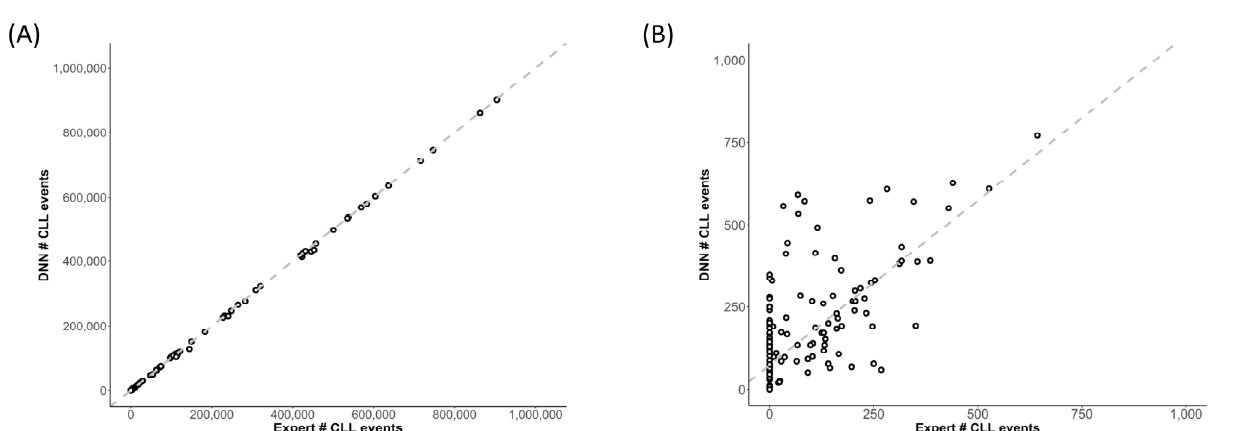
Figure 2. Scatterplots showing expert analysis and DNN inference of abnormal CLL events in the test cohort. ( A , B ) F ‐ DNN inferences showed excellent correlation with the expert abnormal CLL event counts (Pearson correlation coefficient, r > 0.99); ( A ), except at abnormal CLL event counts less than 1000 (r = 0.70). ( B ) The dashed line represents the Passing–Bablok regression line for the F ‐ DNN inferences versus the expert “ground truth”: slope = 1.001 (95% CI: 0.998–1.010) and intercept = 74.000 (95% CI: 60.831–93.835). ( C ) The L ‐ DNN showed an improved correlation with the expert “ground truth” at abnormal CLL event counts less than 1000 (r = 0.96). ( D ) Using the F ‐ DNN infer ‐ ence if greater than or equal to 1000 abnormal events and the L ‐ DNN inference if less than 1000 abnormal events resulted in excellent correlation throughout the analyzed range (r > 0.99) with a Passing–Bablok regression slope of 0.998 (95% CI: 0.995–1.000) and the intercept of 0.000 (95% CI: 0.000–0.046), shown in subplots ( C , D ). 3.2. DNN Optimization For further optimization, a separate DNN with similar architecture to the F ‐ DNN was trained using cases with CLL MRD events < 1000 (L ‐ DNN). The training dataset in ‐ cluded most of the cases (138 of 202) and a total of 145,748,173 events. The L ‐ DNN trained network showed a higher specificity for abnormal cells (>99.9%) with a sensitivity of 80.8% for the test events in the development cohort. Population ‐ specific performance metrics of the L ‐ DNN for this subset of test events in the development cohort are shown in Table 2, and the confusion matrix of L ‐ DNN inferences versus “ground truth” labels is shown in the Supplementary Materials, Table S2. Similar to the F ‐ DNN, the L ‐ DNN demonstrated an AUC ≥ 0.996 for all cell classes of interest in this subset of test events in the development cohort (Figure 1B). The L ‐ DNN demonstrated an improved correlation with the expert analysis at ab ‐ normal CLL event counts less than 1000 (r = 0.96) (Figure 2C). For CLL MRD status desig ‐ nation, a hybrid DNN approach was utilized, whereby both the F ‐ DNN and L ‐ DNN were applied sequentially to cases; F ‐ DNN was applied to all cases and L ‐ DNN was applied only to cases with low ‐ count MRD (<1000 events) predicted by F ‐ DNN (Figure 3). This